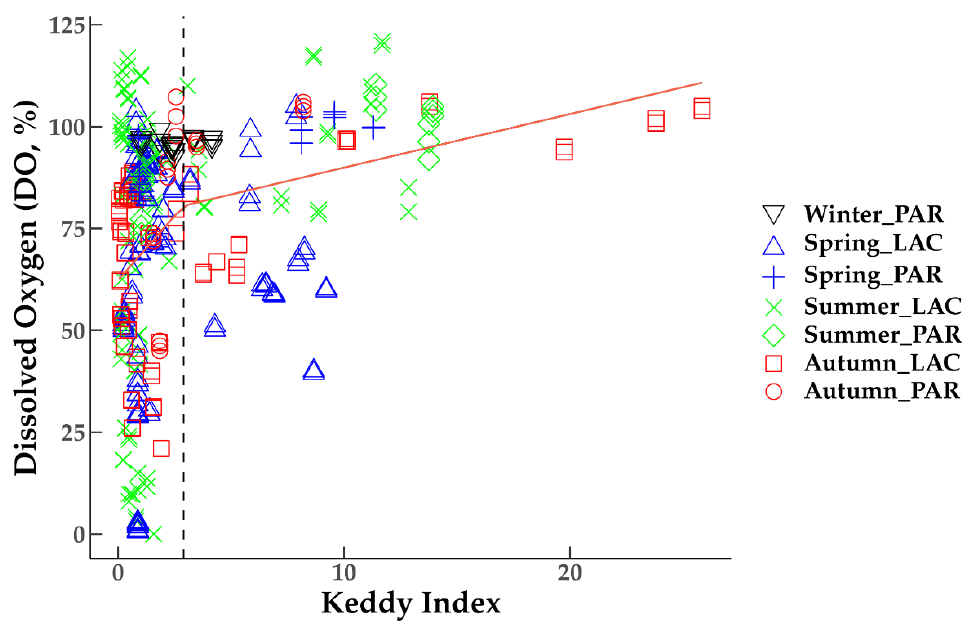
Figure 4. Dependence of DO saturation on wind exposure (Keddy Index). Dashed line is the breakpoint indicating the threshold between low-risk and high-risk of hypoxia/anoxia events in densely vegetated areas.